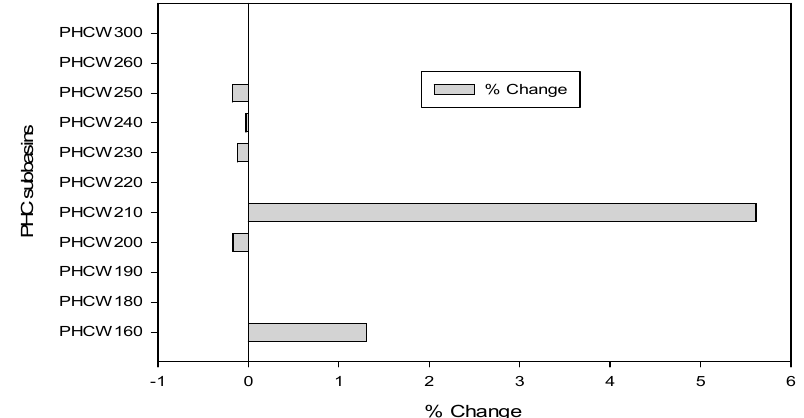
Figure 7. Sub-basin peak flow response to the Phase 1 alternative in the Port-Harcourt/Bonny Basin. Changes in the right direction represent negative changes. It demonstrates that changes in peak flow due to the Phase 1 alternative was greater than changes in peak flow due to the 2003 conditions. In this basin, sub-basin PHC210 experienced the highest peak flow.